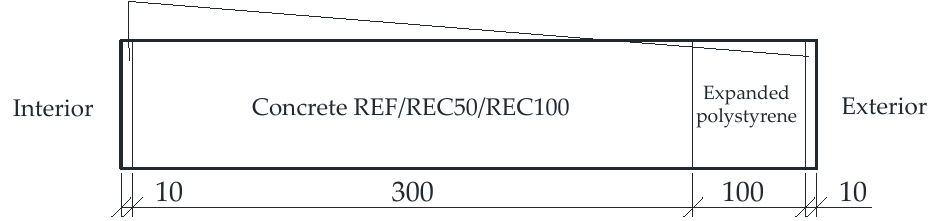
Figure 7. The scheme of the building segment analyzed.